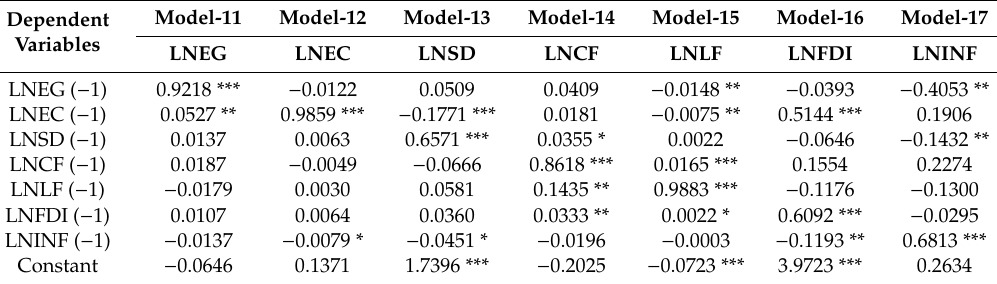
Table 7. Panel Vector Autoregression (PVAR) for the Model